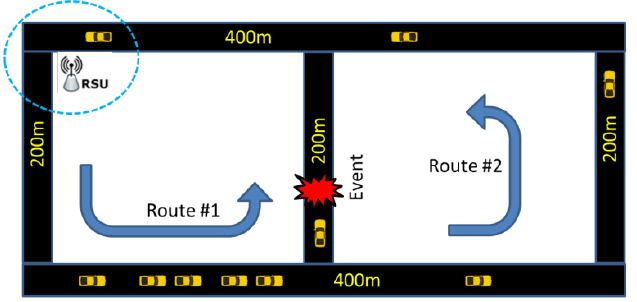
Figure 3. Restricted Scenario.